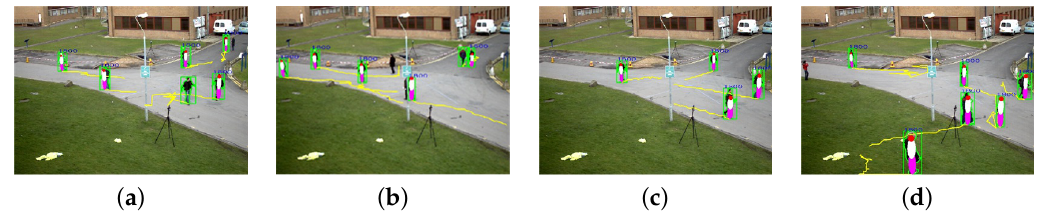
Figure 3. Matching results of the human models: ( a ) an example of the fitting failure in the second human from the right; ( b – d ) the corrected fitting results.